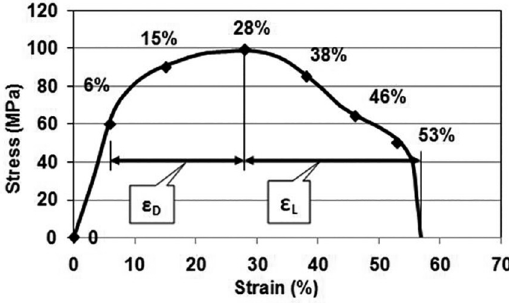
Figure 5: Stress-strain curve showing necking fields and applied deformations.